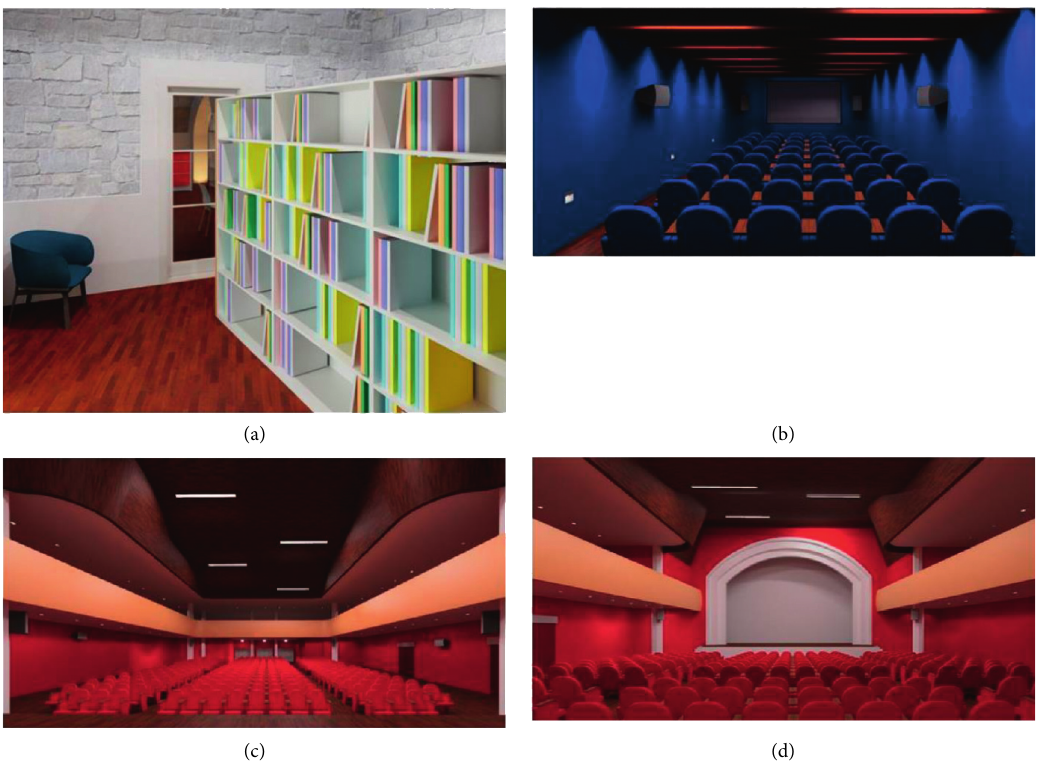
Figure 12: Render simulation of the Supercinema: (a) recreation area, (b) ROOM2 and (c-d) ROOM1.